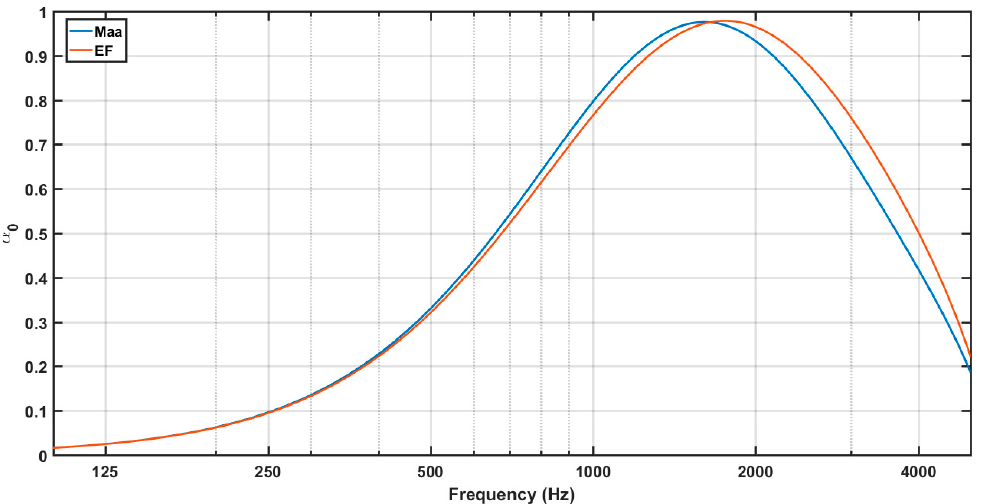
Figure 19. Absorption curves of an SL-MIU with hole perforations, according to the Maa and EF models for ( d 1 , t 1 , φ 1 , d 2 , t 2 , φ 2 , D ) = (3 mm,1 mm,10%,41 µ m,50 µ m,31%,3 cm).